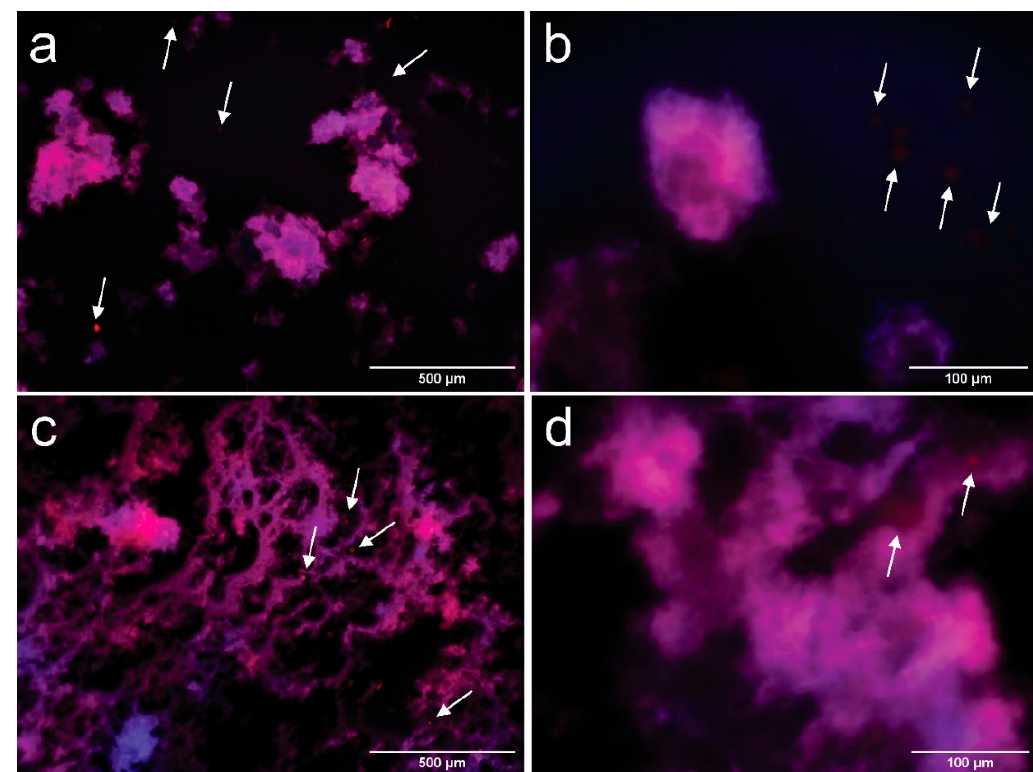
Figure 5. Fluorescence microscopy images of CPCNFs15 taken at 100× ( a ) and 400× ( b ) and CPCNFs70 taken at 100× ( c ) and 400× ( d ) after 1 day of their manufacture. CNFs are colored in blue and oil droplets are colored in red. Oil droplets outside the cellulosic structure are pointed by arrows in the images.